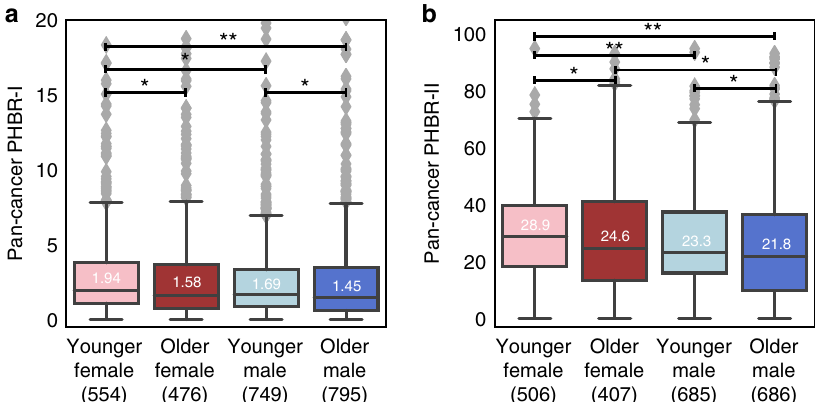
Fig. 2 Integrated sex- and age-speci fi c analysis. a PHBR-I and b PHBR-II scores for the observed driver mutations in pan-cancer integrated sex- and age- speci fi c patient cohorts. One asterisk indicates p values< 0.05 and two asterisks indicates p values < 0.001. All p values were calculated using a one-tailed Mann – Whitney U test. The Benjamini – Hochberg method was used to adjust for multiple comparisons for ( a , b ). Median values are shown in each boxplot. Exact p values for ( a ) include: YF, OM: 0.7e − 05; YF, OF: 0.005; YF, YM: 0.008; YM, OM: 0.008; OF, OM: 0.08; OF, YM: 0.22. Exact p values for ( f ) include: YF, OM: 5.51e − 07; YF, YM: 0.0003; YM, OM: 0.035; YF, OF: 0.038; OF, YM: 0.17. Y = younger, O = older, F = female, M = male. All box plots include the median line, the box denotes the interquartile range (IQR), whiskers denote the rest of the data distribution and outliers are denoted by points greater than ±1.5 × IQR.